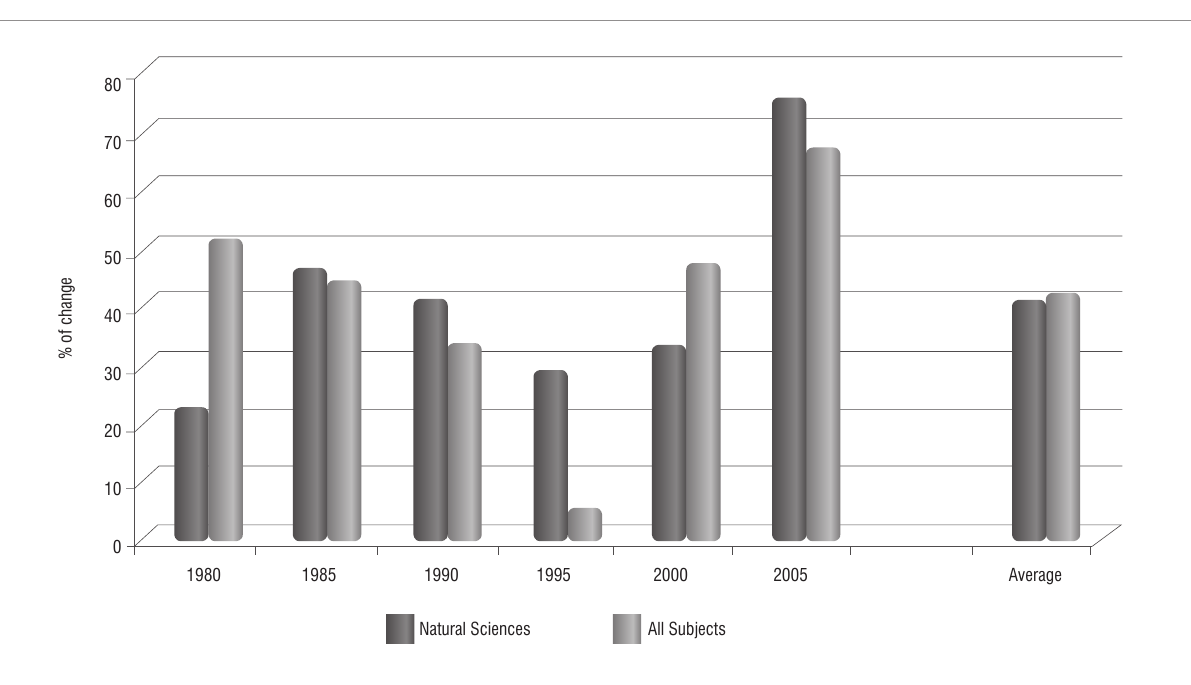
Figure 1: Growth of publications in the natural sciences and in ‘all subjects’ in South Africa, 1975–2005.